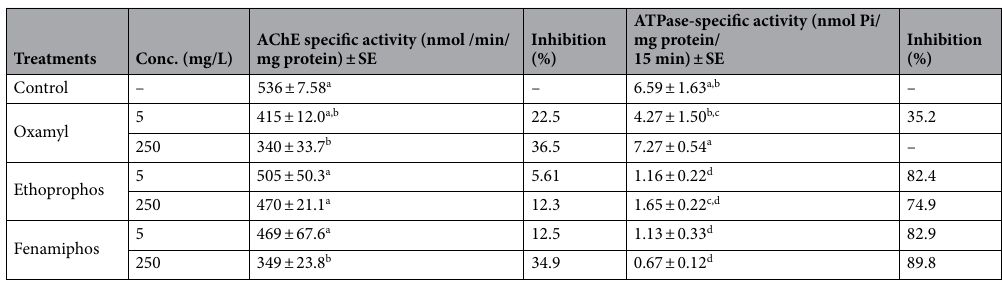
Table 3. AChE (nmol/min/mg protein) and ATPase (nmol Pi/mg protein/15 min) specific activity and the inhibition (%) of Meloidogyne incognita with the oxamyl, ethoprophos, and fenamiphos treatments after 48 h post-treatment. Each value is the mean ± SE of 3 replicates, means within the same column followed by the same letter are not significantly different ( P ≤ 0.05; Duncan’s multiple range test).